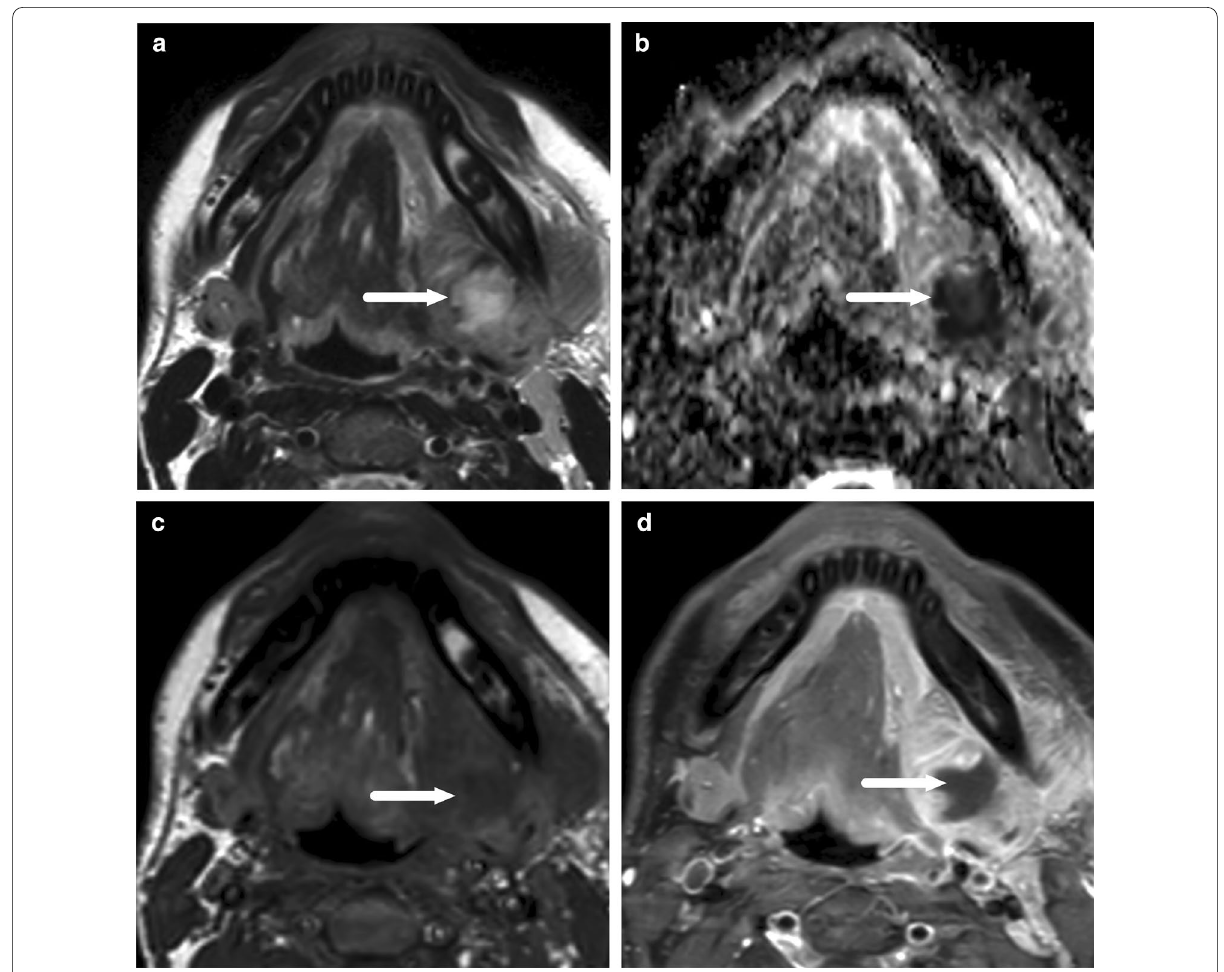
Fig. 4 Diagnostic criteria for an abscess on MRI: axial T2-weighted ( a ), pre-contrast T1-weighted ( c ), fat-suppressed post-contrast T1-weighted ( d ) images, and an ADC map ( b ). A submandibular space odontogenic abscess (arrows) shows intermediate to high T2-signal ( a ), no enhancement after contrast injection ( c , d ), and restricted diffusion as indicated by low ADC values ( b )